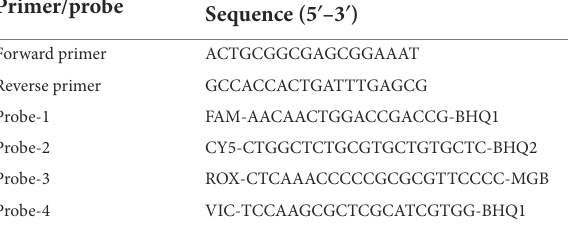
TABLE 2 Primer and probe sequences used in multiplex real-time fluorescent quantitative